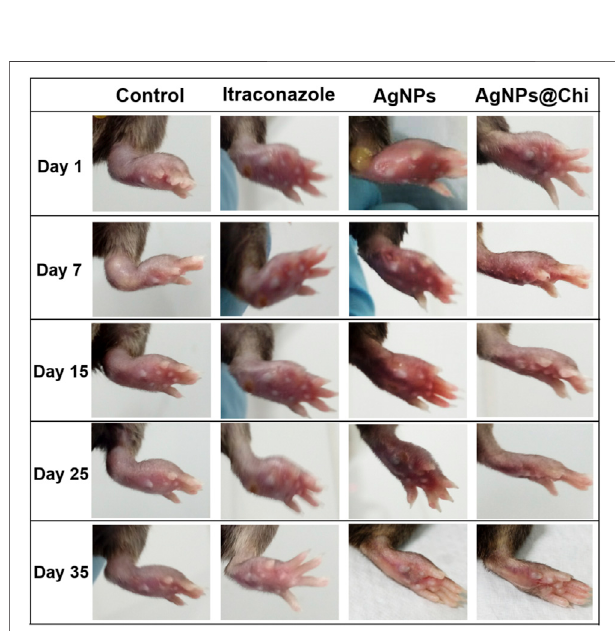
FIGURE 5 | Protective effect of nanoparticles in a murine model of mild sporotrichosis. Cells (5 × 10 6 cells/25 μ l) of S. brasiliensis was inoculated into thepawC57BL/6mice.Treatmentswithnanocomposites wereperformedby spray (three applications from a 5 μ g/ml silver suspension). Itraconazole was administered intravenously (0.5 mg/kg/day/per tail). For intravenous treatment, mice were previously anesthetizedwithketamineand xylazine. The images correspond to days 1 to day 35 of the treatment started 25 days ’ post-infection. Mice treated with AgNPs@Chi exhibited better recovery and during the 3 weeks of monitoring after the end of the treatment, they showed no lesions or signs of